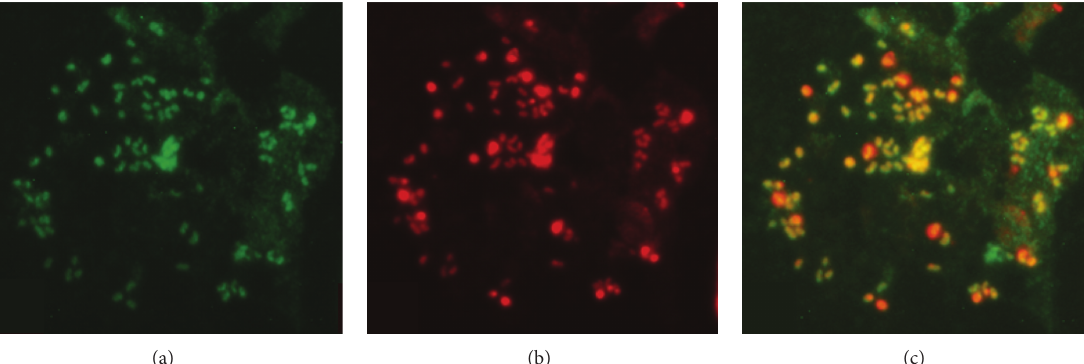
Figure3:SubcellularlocalisationofPtcB.Fluorescencemicroscopyof D.discoideum cells(a)expressingaPtcB:GFPfusionprotein,(b)stained with Mitotracker, (c) indicating that the fusion protein and the mitochondria colocalise.